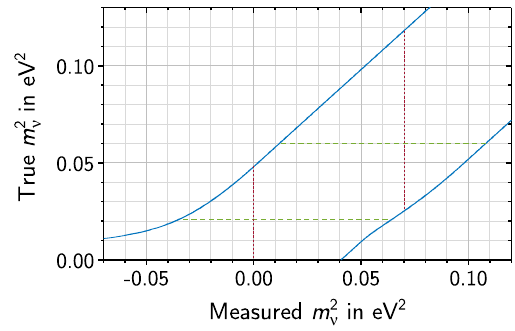
Fig. 15 Frequentist confidence belt (95%C.L.) constructed according to the unified approach by Feldman and Cousins [57]. In this example, the horizontal ranges (green dashed lines) are constructed by choosing 95% of the m 2 ν estimates from an ensemble test with fixed true m 2 ν , following the ordering principle. These horizontal ranges define the edges of the confidence belt (blue solid lines). The subsequent result of an actual neutrino mass measurement (x-axis, indicated by red dotted lines) is used to select the vertical intersections with the confidence belt todeterminethereportingofanupperlimit(e.g.incaseof m 2 ν = 0 eV 2 ) or a two-sided confidence interval (e.g. in case of m 2 ν = 0 . 07 eV 2